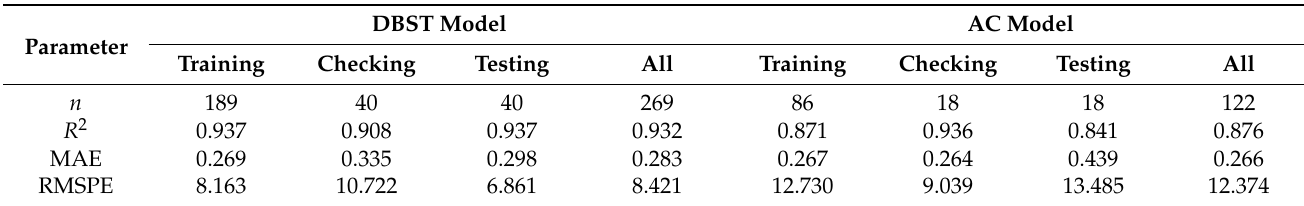
Table 5. Performance of the DBST and the AC models of training, checking, testing, and all data.